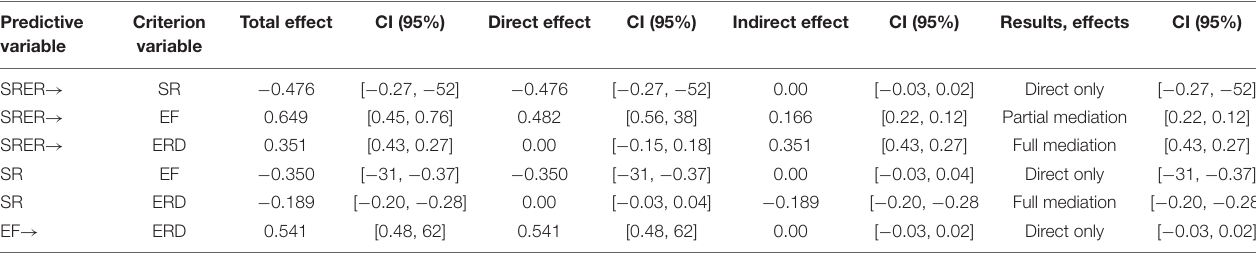
TABLE 7 | Total, indirect, and direct effects of the variables in this study, and 95% bootstrap confidence intervals (CI). Predictive